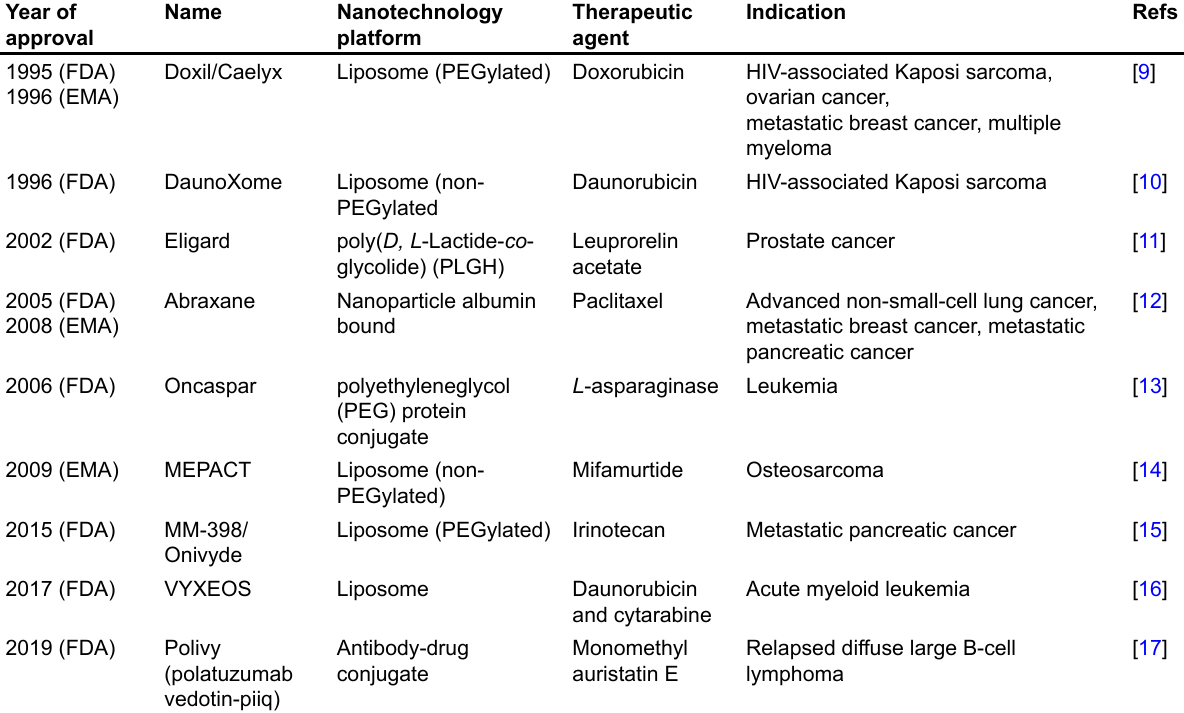
Table 2. Examples of clinically approved nanomedicine Year